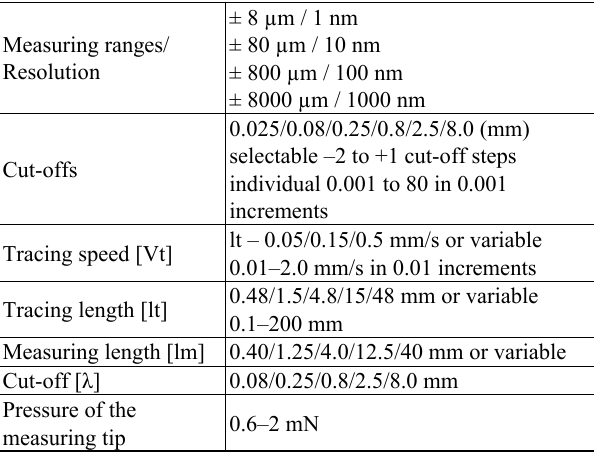
Table 1. Hommel Tester 8000 – technical specifications